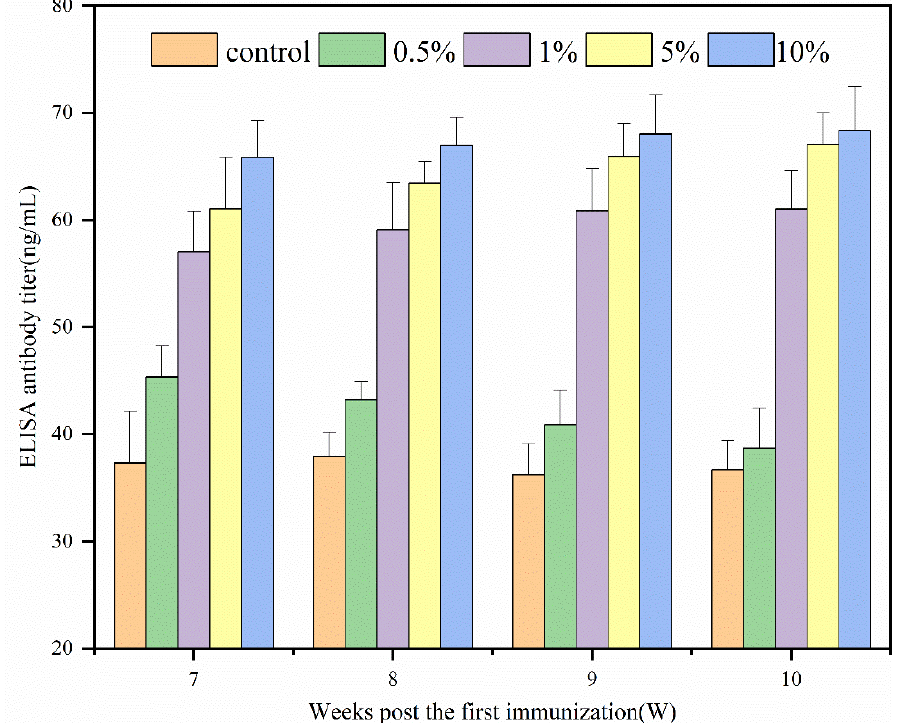
Figure 11. ELISA antibody dynamics regularity of serum in guinea pigs.